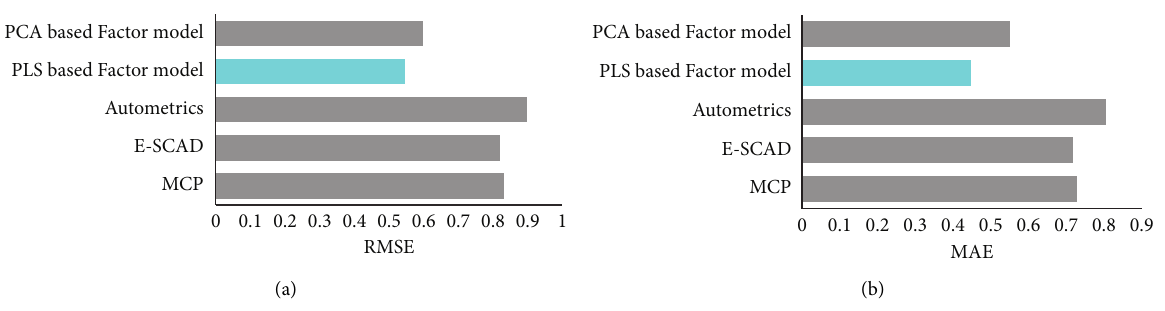
Figure 7: Forecast comparison using macroeconomic